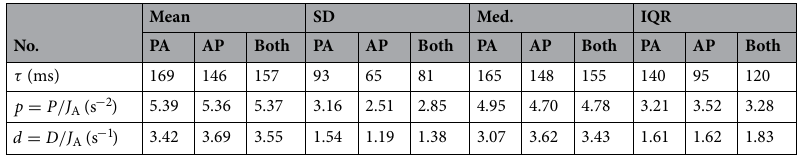
Table 1. Statistics of the estimated reaction time delay τ and the estimated control gains p = P / J A and d = D / J A : Mean, Standard Deviation (SD), Median (Med.), Interquartile Range (IQR). Parameters are listed for the trials in the PA and the AP directions separately and together (both).